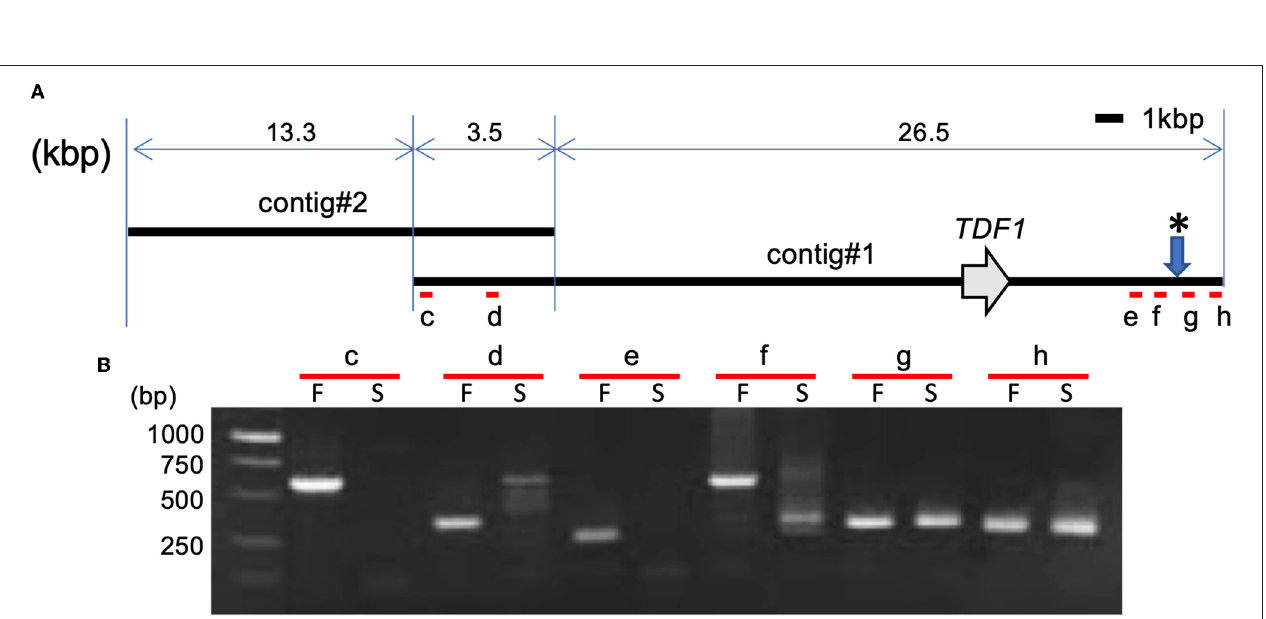
FIGURE 5 | Structural analysis of LflTDF1 flanking region. (A) Location of LflTDF1 and nanopore sequencing contigs obtained from a pollen-fertile line. (B) PCR amplification in the pollen-fertile genotype (F) and sterile AR01 (S) using the primer pairs (c to h) that were designed within the contig #1. Since five pollen-fertile genotypes amplified the same sized amplicon in the respective primer set, the amplicon of one genotype is represented as an example. * indicates the chromosome breaking points inferred from the PCR amplification of each primer